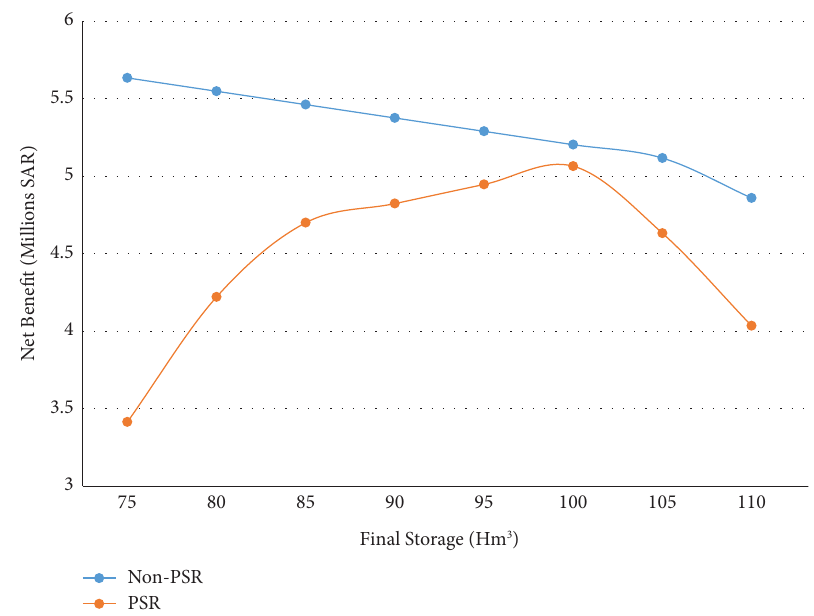
Figure 5: Net beneft using non-PSR and PSR scenarios for diferent fnal storages.